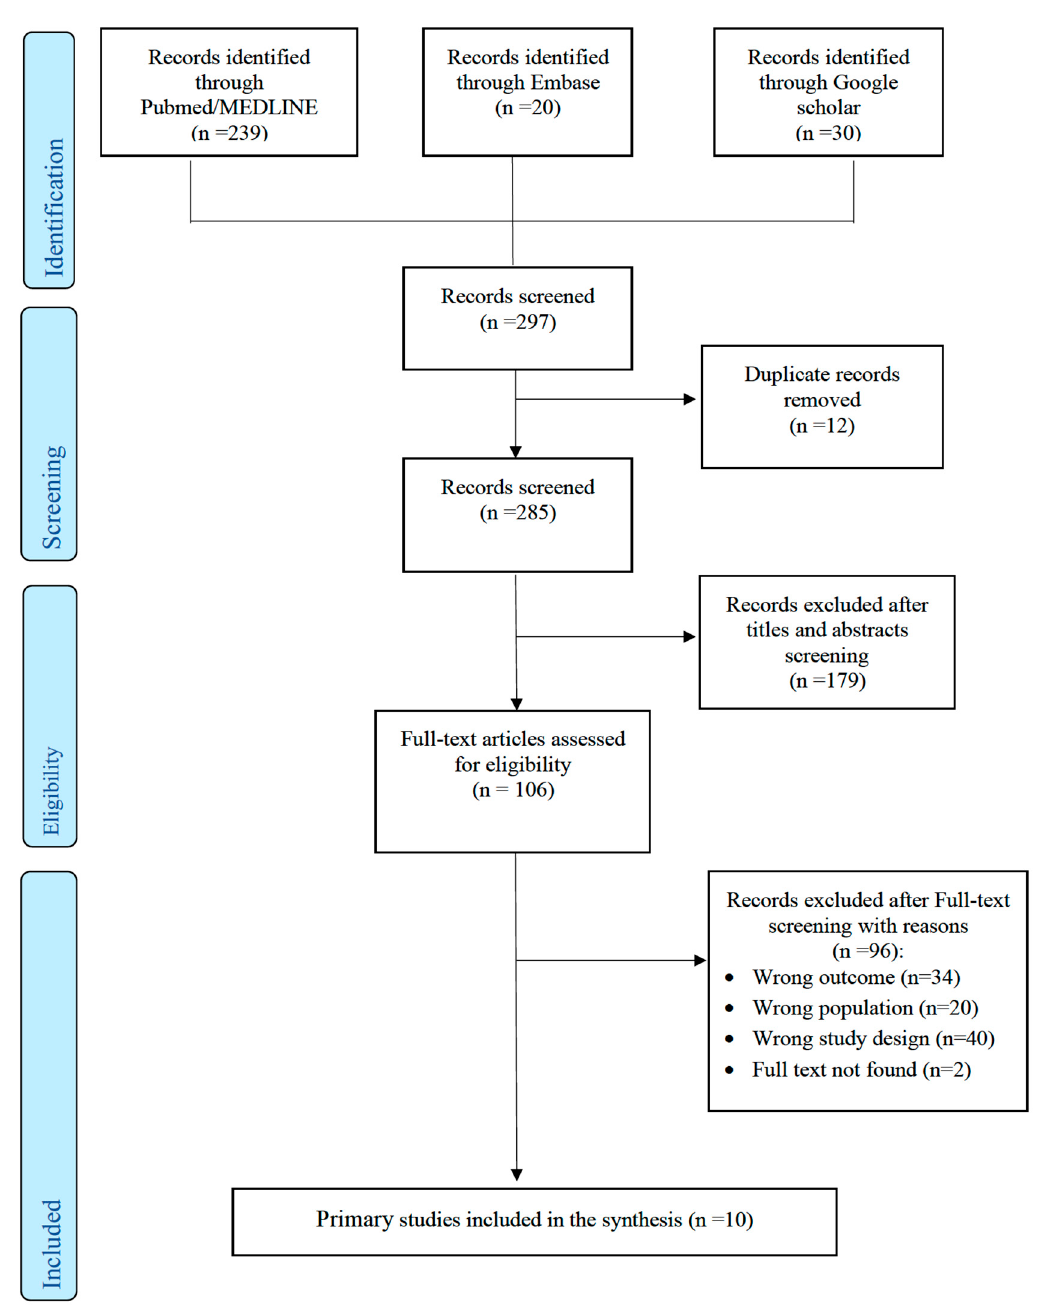
Figure 1. PRISMA 2009 flowchart of the systematic review’s inclusion process.